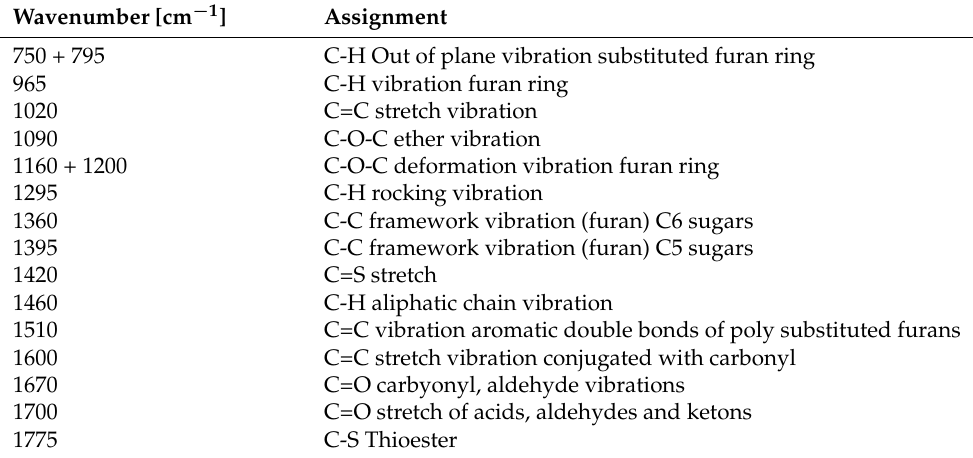
Table 3. Assignment of IR-spectra